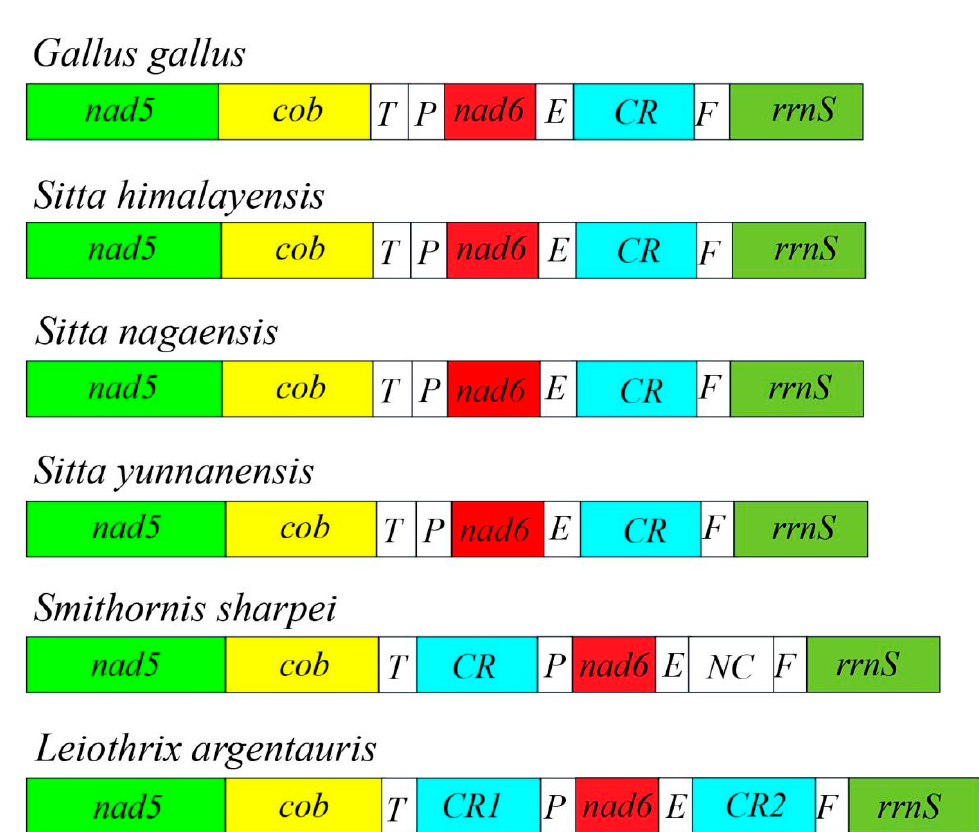
Figure 2. Mitochondrial gene order from nad5 to 12S rRNA as in three Sitta species. Table 2. Annotation of the complete mitogenome of the three Sitta species in this study.